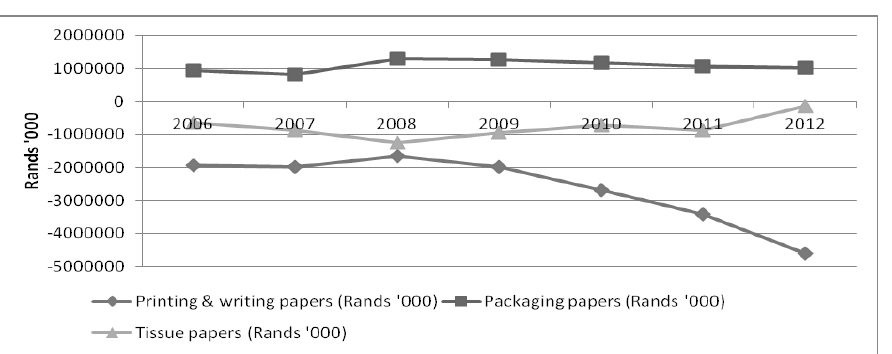
FIGURE 3: Balance of Trade (exports-imports) Source: Derived from PAMSA,